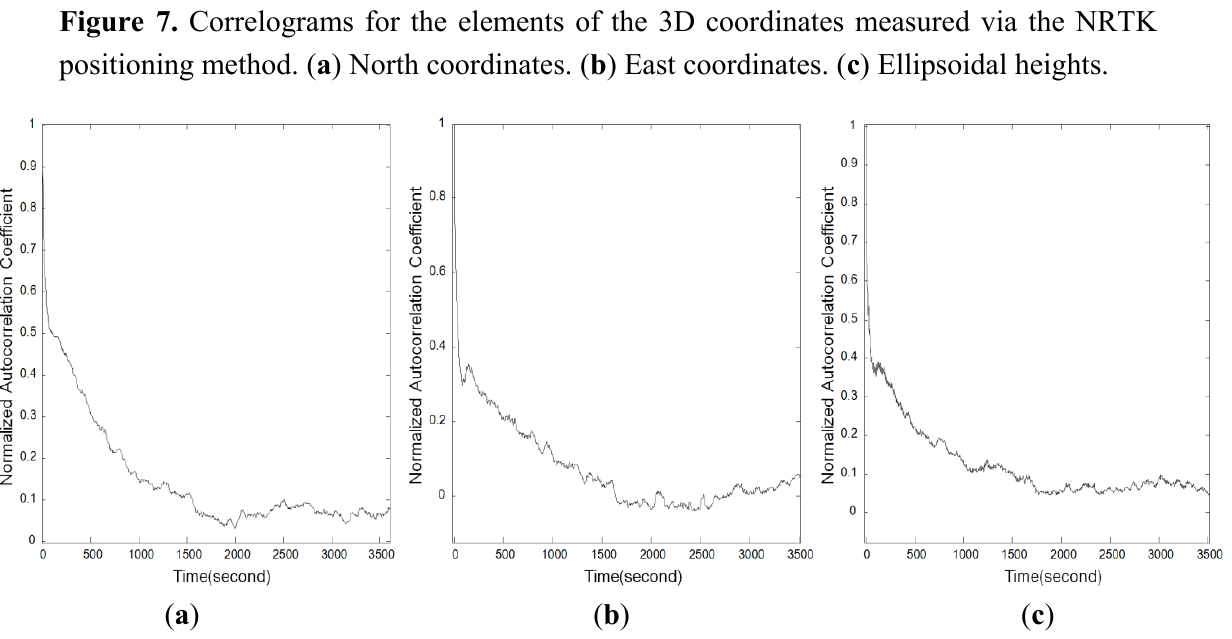
Figure 7. Correlograms for the elements of the 3D coordinates measured via the NRTK